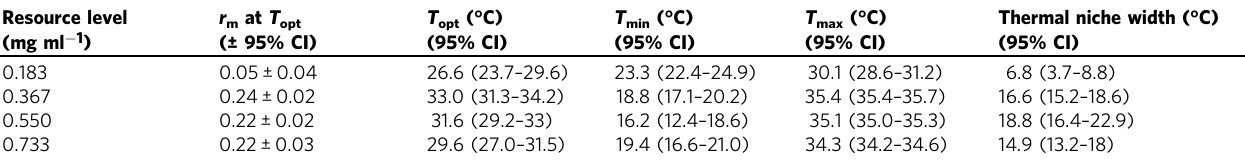
−0.10.00.10.20.3 Fig. 2 The effect of larval competition on the thermal response of population-level Ae. aegypti fi tness ( r m ) with bootstrapped 95% prediction bounds. a Competition at 0.183 mg ml − 1 signi fi cantly depressed r m across the entire temperature range and narrowed its thermal niche width compared to the higher resource levels (non-overlapping 95% prediction bounds, Table 3). Symbols denote matrix projection estimates with 95% con fi dence intervals (Table 2). b Competition at 0.183 mg ml − 1 signi fi cantly (non-overlapping 95% con fi dence intervals) lowered maximal r m and caused it to peak ( r m T opt ) at a signi fi cantly lower temperature than at the intermediate resource level (0.367 mg ml − 1 ). Predicted r m T opt at 0.183 mg ml − 1 indicates that competition could decrease r m T opt by 6.4 °C, when compared to the intermediate resource level (0.367 mg ml − 1 , Table 3). The Kamykowski model 82 (Eq. 2) predictions are in Supplementary Data 2. Table 3 Parameter estimates of the thermal performance curves of population fi tness ( r m ) by resource level. Resource level (mg ml − 1 ) Non-overlapping 95% con fi dence intervals (CIs)indicate that larval competition at the lowest resource level(0.183mgml − 1 ) signi fi cantly depressed maximal growth ( r m at T opt ) compared to the higher resource levels. Competition at 0.183mgml − 1 caused a signi fi cant decrease in r m T opt compared to r m T opt at 0.367mgml − 1 ; it also caused a signi fi cantly narrower thermal niche width (the thermal maximum for fi tness, T max , minus the thermal minimum, T min ) compared to the higher resource